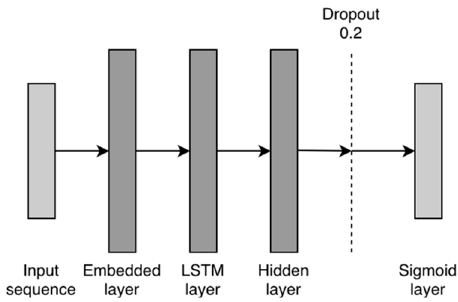
Figure 2. The set of layers stacked that together form the LSTM classification architecture.